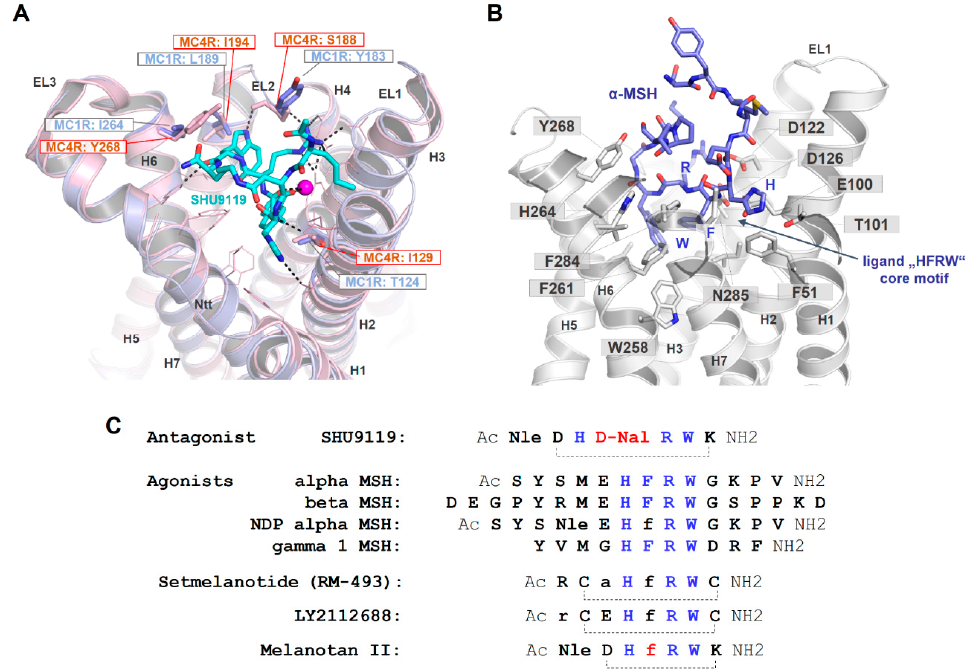
Figure 7. Binding site comparison between the MC4R bound with SHU9119 and the MC1R, and α -MSH in complex with the MC4R. ( A ) The MC4R (light-magenta backbone) binds SHU9119 into a cavity between the extracellular loops (ELs) and the transmembrane helices (H). Visualized are amino acids covering the ligand binding site (lines). Sticks (labeled) represent residues in the binding site that vary compared to the MC1R. These four different amino acids are also shown for the MC1R (blue) at a superimposed MC1R model based on the MC4R crystal structure. Specifically, the difference in corresponding MC4R S188 and MC1R Y183 is likely highly important for SHU9119 binding, because this ligand interacts with the side chain of S188 that should differ in the MC1R with a tyrosine at this position. In contrast to an antagonistic effect of SHU9119 on the MC4R, this ligand activates the MC1R. ( B ) Because all peptidic MCR ligands share a core motif essential for recognition by the receptor (see also C), few essential interactions observed for SHU9119 in the complex crystal structure with the MC4R may also be involved in MSH binding, e.g., ( α -MSH/receptor) H6/T101 and R8/D126. Using these interactions as constraints for α -MSH docking into the MC4R, W9, in particular, may be differentially located in the receptor compared to W7 of SHU9119. This is essentially caused by the large and bulky aromatic D-Nal (D-Naphtylalanine) in SHU9119 instead of the F7 in α -MSH, which leads to differences in the orientation of the tryptophan. ( C ) This sequence comparison highlights the similarities and distinct features of MC4R ligands. Of note, the chemical difference between SHU9119 (antagonist) and melanotan II (agonist) is located at a single position (red, D-Nal vs. D-Phe), leading to the opposite ligand effect (Nle: norleucine).